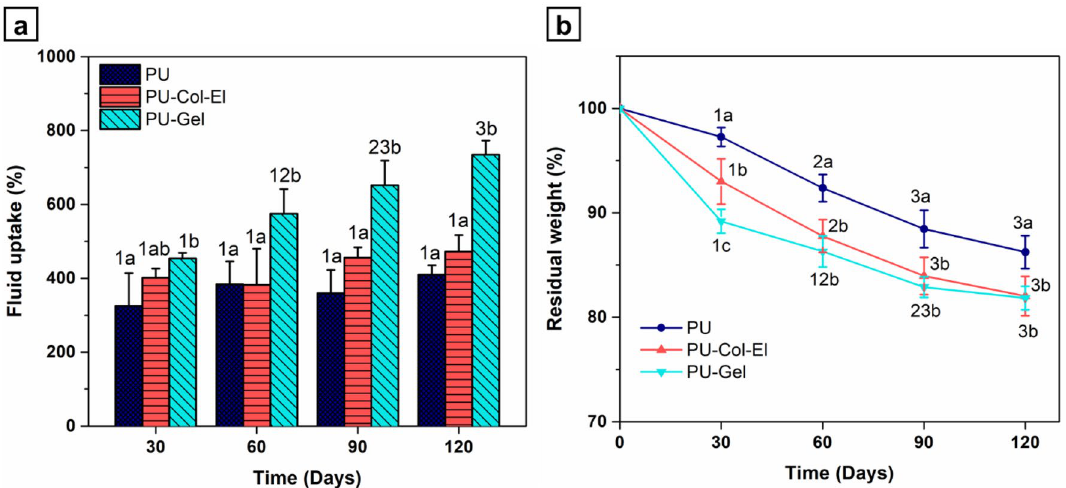
Figure 5. Time profiles of ( a ) fluid uptake and ( b ) in vitro degradation of scaffolds. Statistical differences were analyzed using two-way ANOVA with a Bonferroni post-hoc test (a, b, c denotes a significant difference of p < 0.05 between scaffolds; and 1, 2, 3 indicates a significant difference of p < 0.05 between time points).